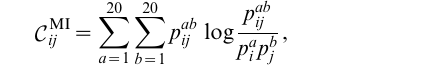
frequencies in each column ( p ( a ) frequency of a th amino acid in i column i ) with the distribution of amino acids in column pairs frequency of the pair a and b in columns i and j respectively). ( p ( ab ) ij The results are organized into a matrix of correlation values C ij .